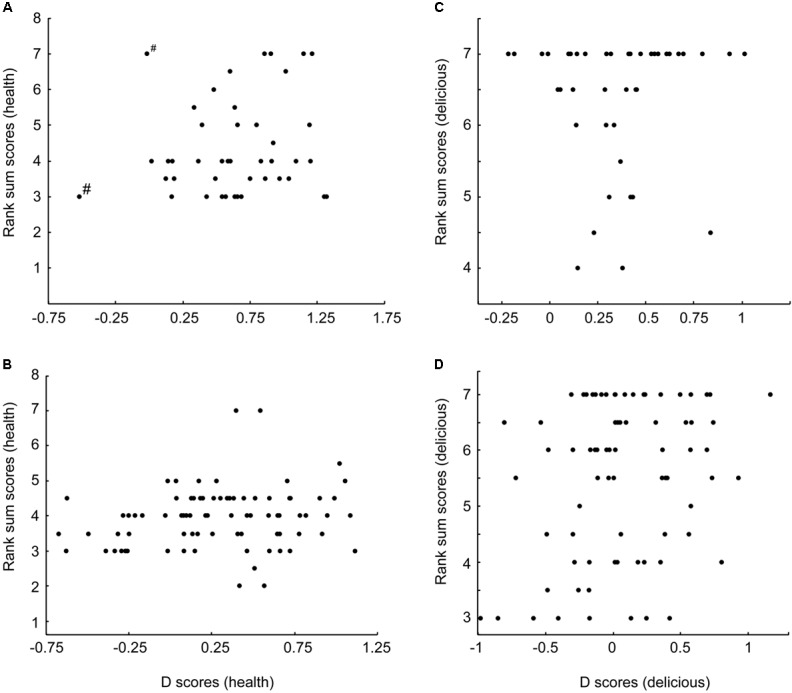
Neither men (A) nor women (B) exhibited a correlation between the strengths of their implicit and explicit measures of meat healthiness. Women exhibited a positive correlation between their implicit and explicit measures of meat deliciousness (D), while men did not (C). #Removal of these apparent outliers from (A) does not reveal a significant correlation, p = 0.149.